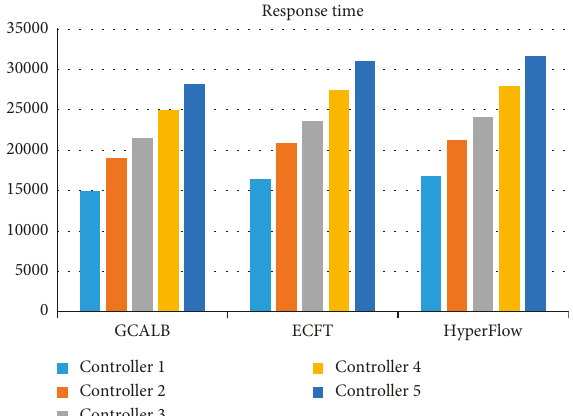
Figure 17: Comparison among average throughputs for GCALB, ECFT, and HyperFlow for four slave controller model.